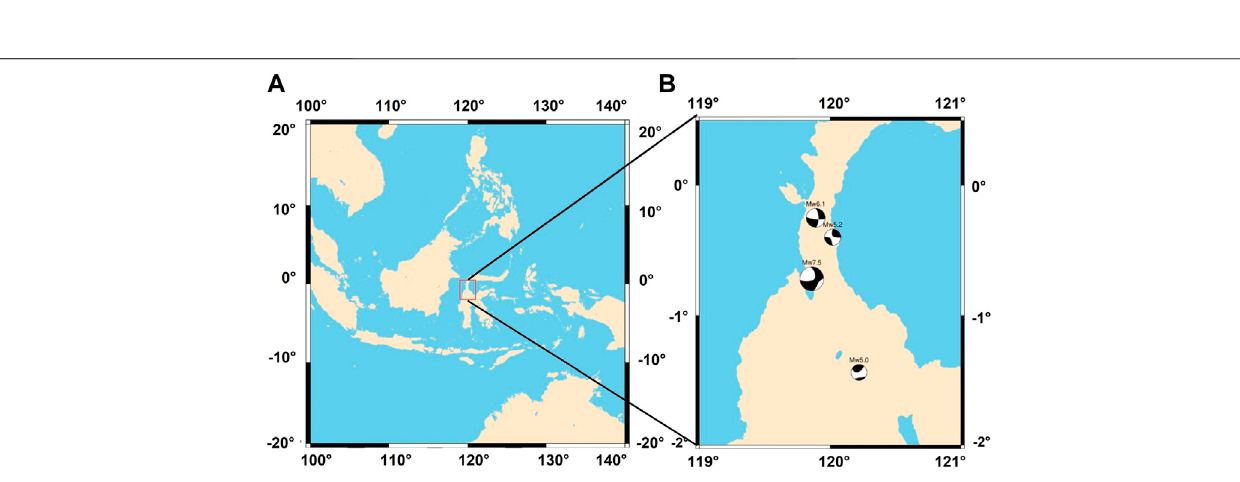
FIGURE 10 | (A) Location index (window). (B) Earthquake focal mechanisms of the 28 September 2018 Palu Earthquake. Moment tensor values were obtained from the Global CMT Catalog